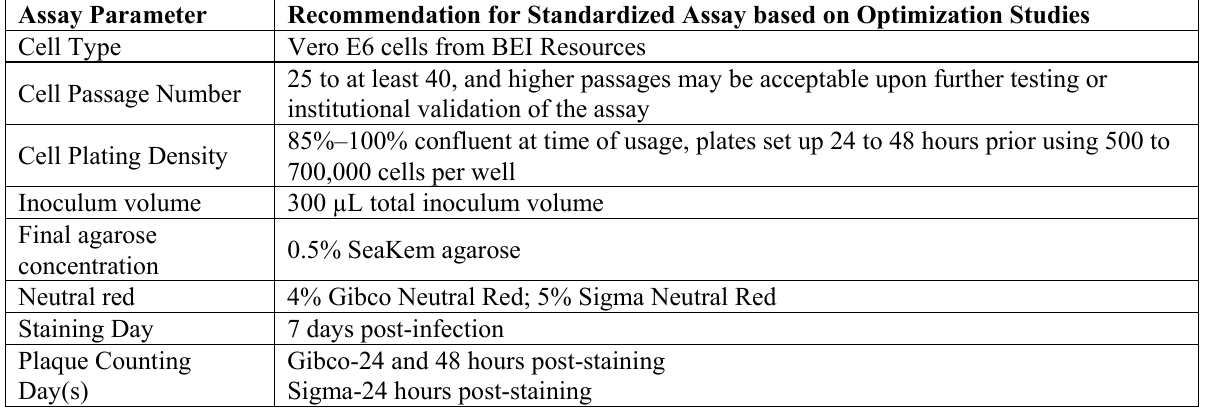
Table 3. Standardized filovirus plaque assay suggested for use in FANG studies. Assay Parameter Recommendation for Standardized Assay based on Optimization